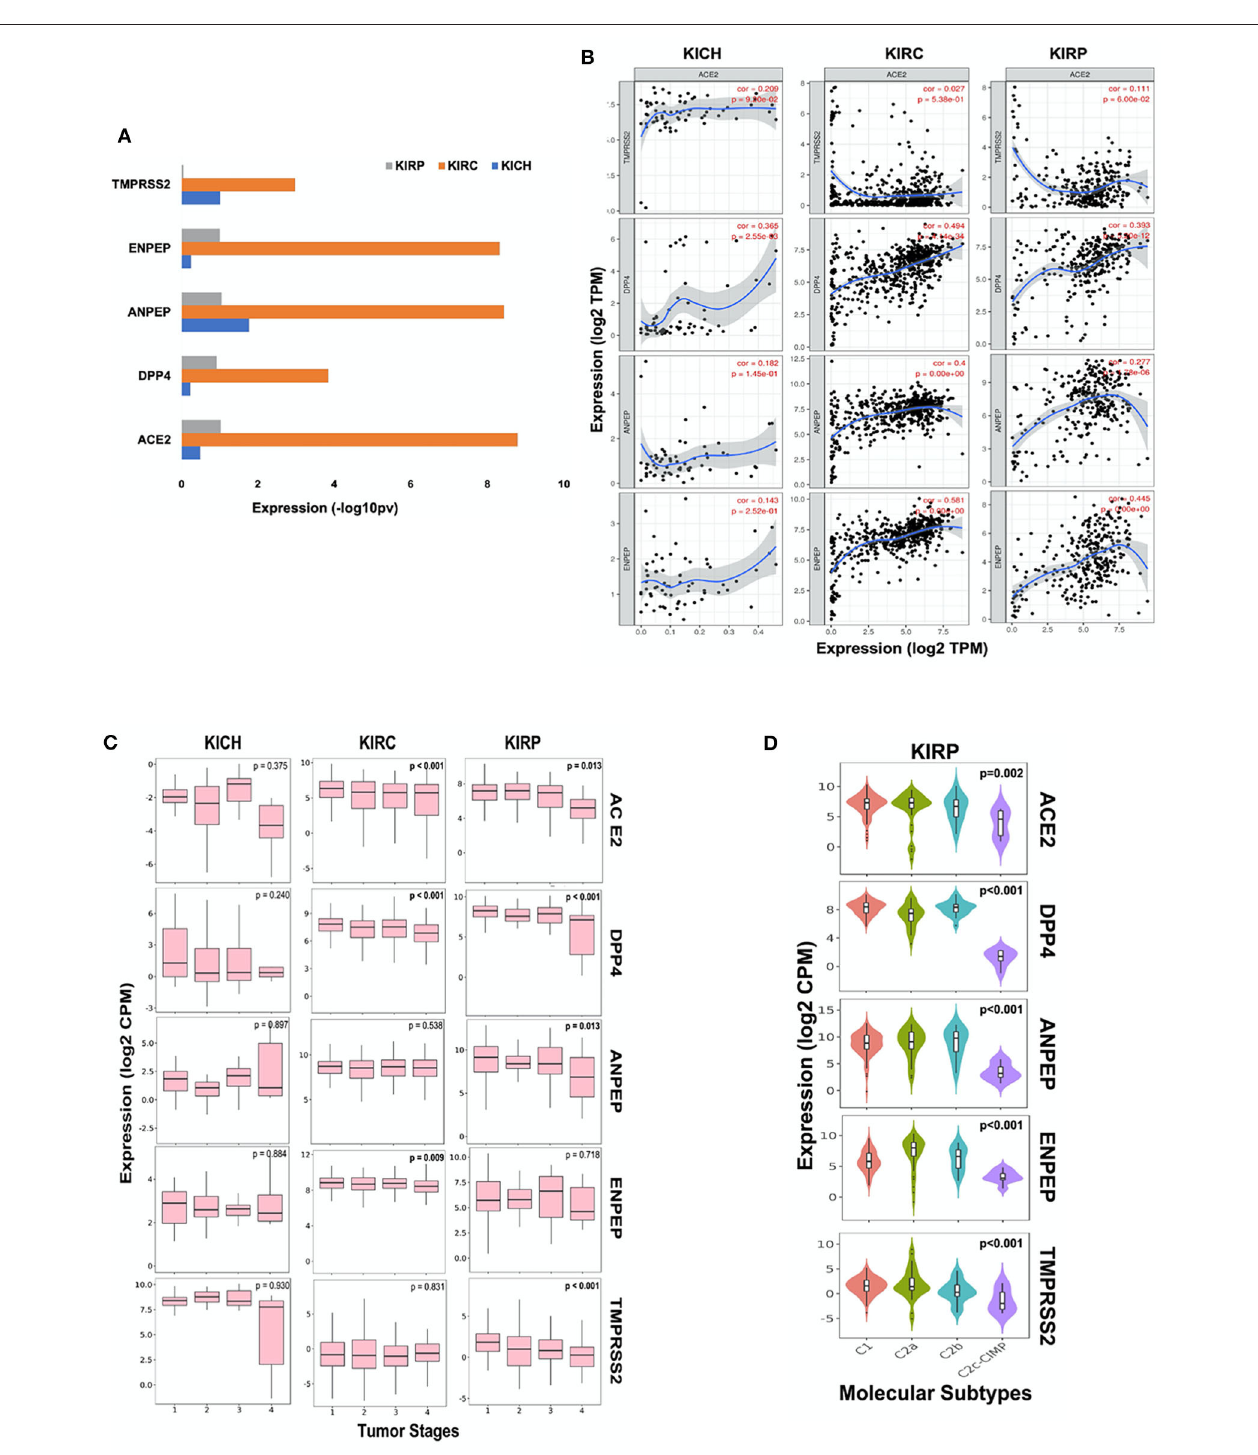
FIGURE 2 | Coronavirus receptors in Renal carcinoma. (A) The bar graph depicting a comparison of coronavirus receptor expression in different subtypes (KIRC, n = 515; KIRP, n = 279; KICH, n = 65) of renal carcinoma. KIRC exhibited the highest expression of all coronavirus receptors as compared to whereas KIRP exhibited negligible expression of TMPSS2. (B) Correlation scatterplot of ACE2 with DPP4, ANPEP, ENPEP, and TMPRSS2 in all renal carcinoma subtypes. ACE2 was significantly correlated with DPP4 in all renal carcinoma subtypes. (C) Boxplot for coronavirus receptors expression in different tumor stages. ACE2 and DPP4 exhibited significant negative correlation with tumor stages in KIRC ( n = 515) and KIRP ( n = 279). (D) Violin plot for coronavirus receptors expression across various molecular subtypes in KIRP tumors ( n = 279). All coronavirus receptors showed significantly increased expression in C1, C2a, and C2b subtypes compared to the C2c-CIMP subtype. KIRP, Kidney renal papillary cell carcinoma; KIRC, Kidney renal clear cell carcinoma; KICH, Kidney renal chromophobe.